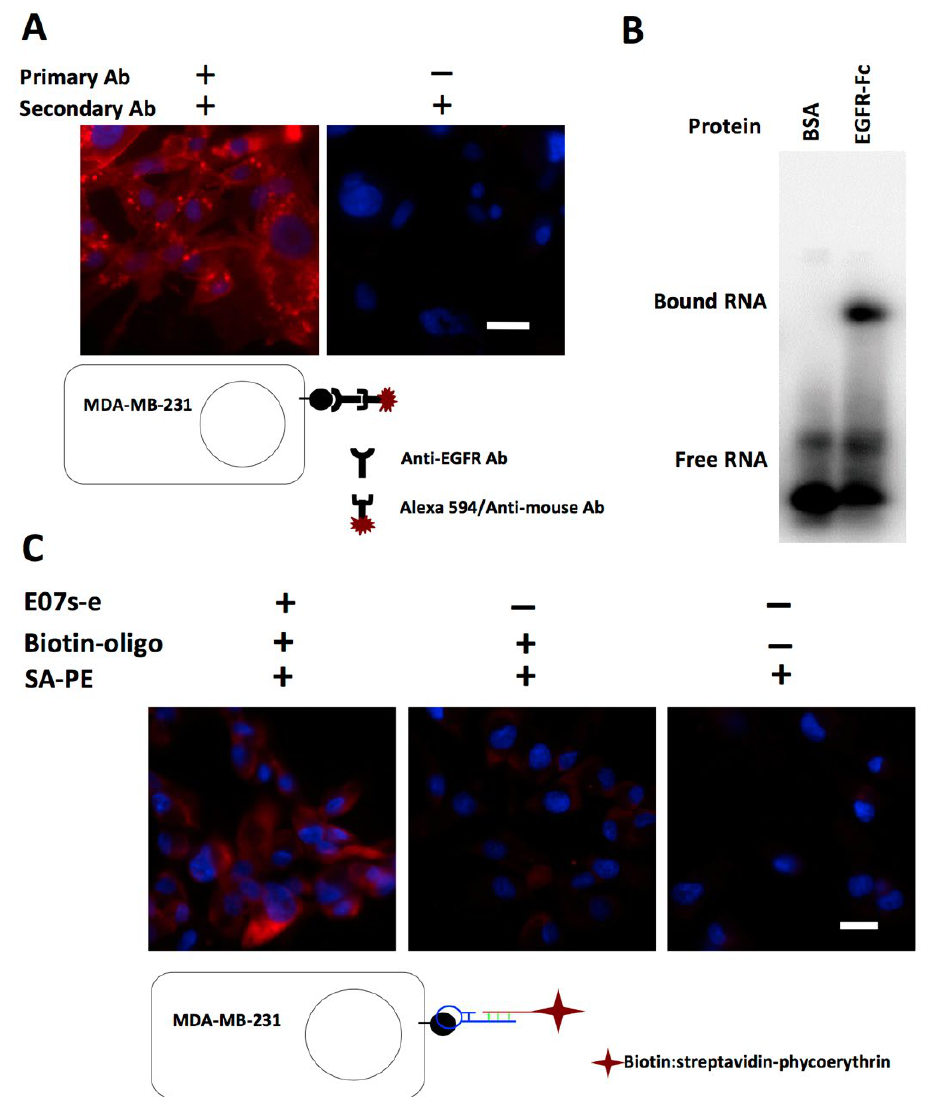
Figure 3. Binding of EGFR aptamer to MDA-MB-231 cells. ( A ) Expression of EGFR on MDA-MB-231 breast cancer cells. EGFR was detected using anti-EGFR antibody and anti-mouse Alexa Fluor 594 (red signal). The blue signal indicates the nuclear stain DAPI. Cells containing the primary anti-EGFR antibody (left panel) show a strong red signal compared to the “no-primary antibody” control (right panel). ( B ) Binding of E07s-e to EGFR-Fc. In total, 100 nM of the protein was used in an EMSA (5% ntive polyacrylamide gel, acrylamide:bis-acylamide was 70:1 with 1 / 2 x TGB buffer with 2.5